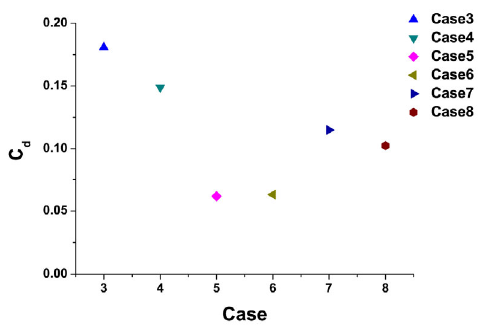
Figure 17. The time ‐ averaged drag coefficients of all the vegetated cases. Figure 17. The time-averaged drag coefficients of all the vegetated